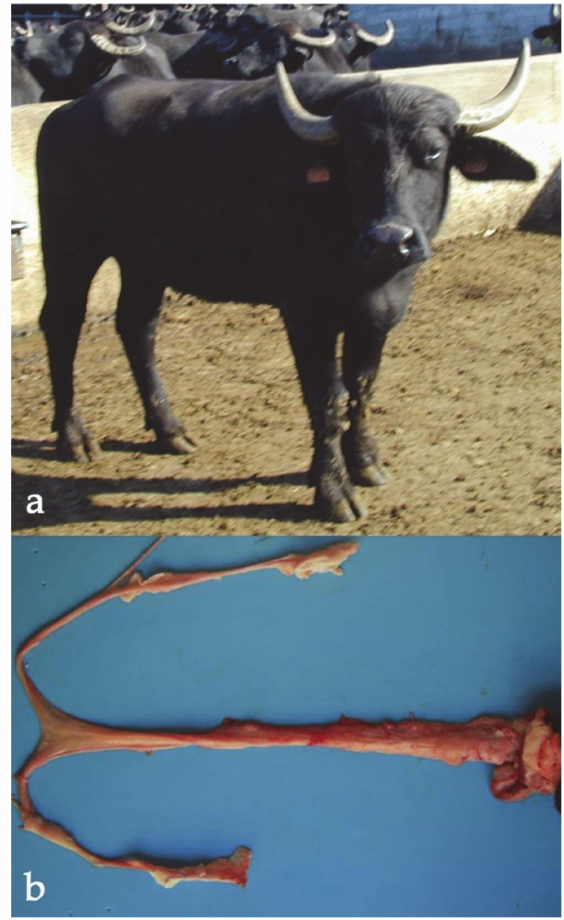
Figure 5. ( a ) River buffalo female showing normal body conformation and external genitalia but found with XX/XY mosaicism (free-martin). Note the atrophic uterine body ( b